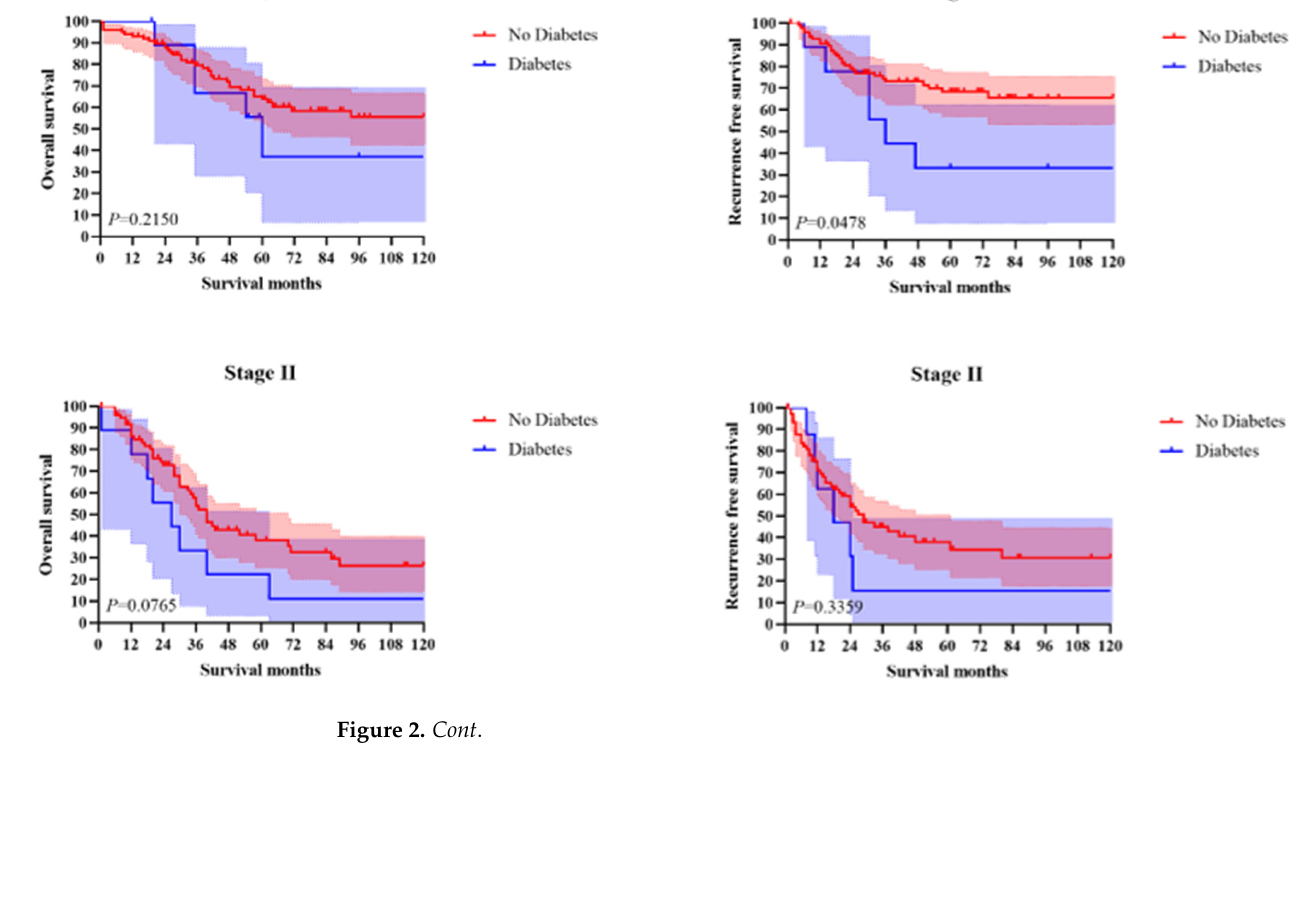
Figure 2. Subgroup survival analysis according to the tumor stage. 4. Discussions The impact of diabetes on the short-term and long-term outcomes of digestive tumors is still controversial. To the best of our knowledge, no previous study has been reported about the association between diabetes and outcomes of AC patients who underwent curative pancreaticoduodenectomy. In the current study, we found that diabetes did not increase the risk of postoperative complications in AC patients. However, diabetes might adversely